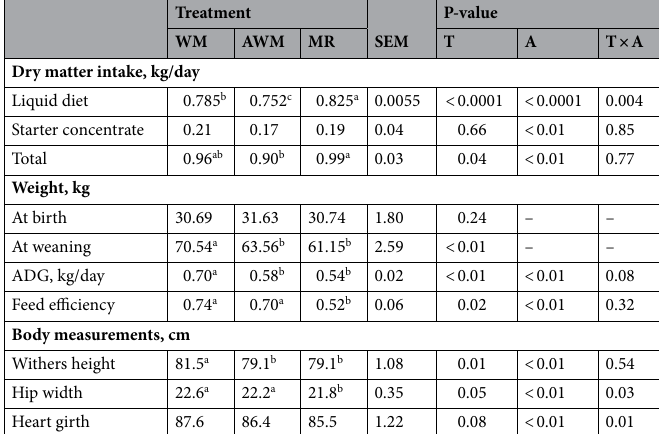
Table 1. Performance of preweaning dairy calves fed different liquid diets. WM whole milk, AWM acidified whole milk, MR milk replacer, SEM standard error of the mean, T treatment effect, A age effect, T×A treatment × age interaction effect ( P < 0.05). a , b , c Means within a row with different superscripts are significantly different (P ≤